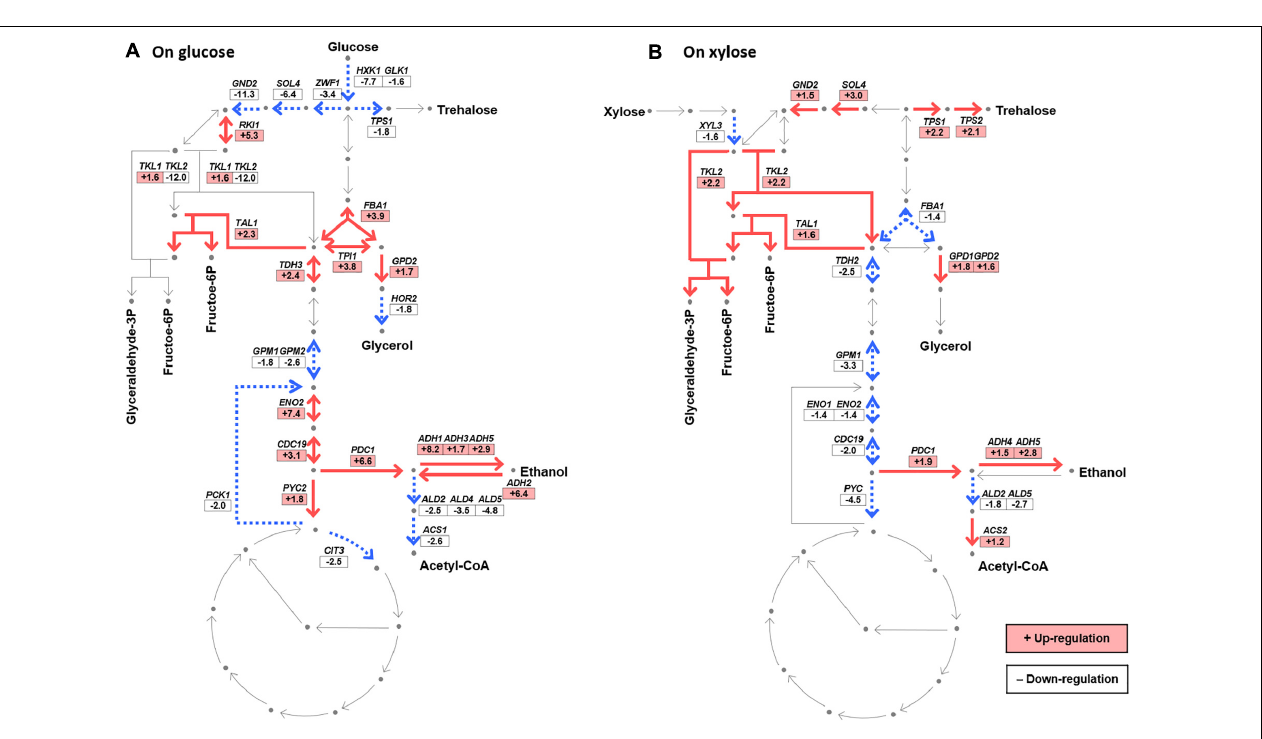
FIGURE 3 | Gene sets and their genes that are oppositely affected by (cid:49) gcr2 . RNA samples were extracted from exponentially growing SR7 and SR7 (cid:49) gcr2 strains on glucose and xylose.